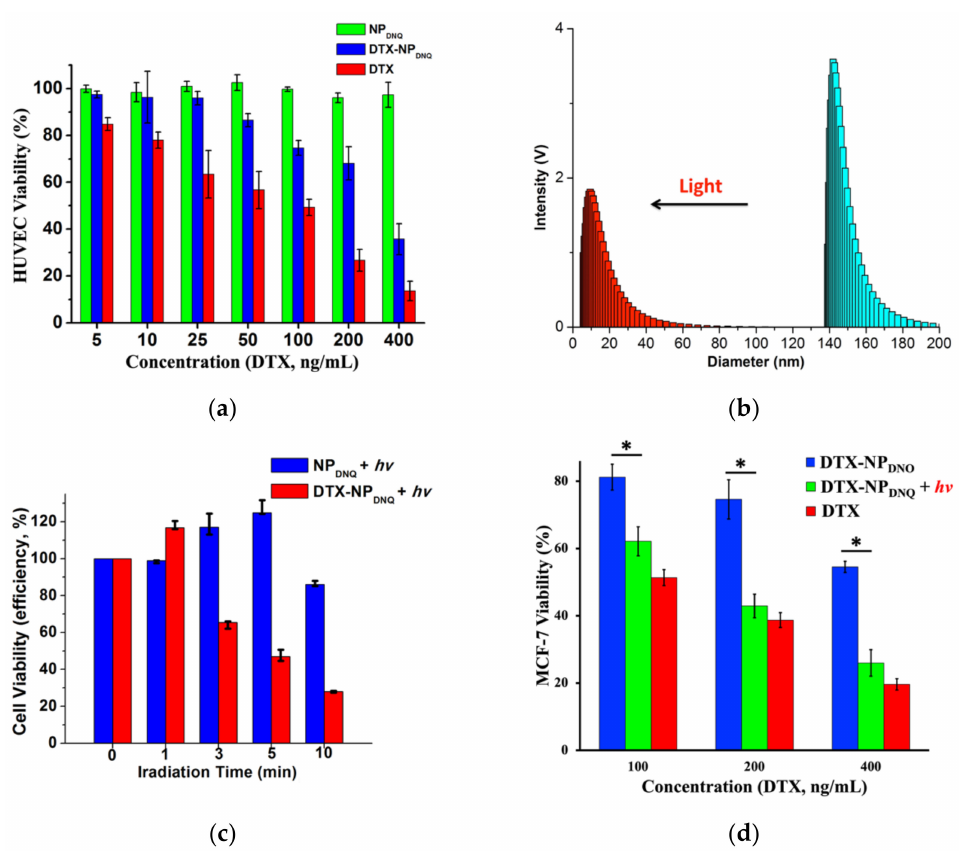
Figure 5. ( a ) Cytotoxicity of HUVECs with NP DNQ (green bar), DTX-NP DNQ (blue bar), and DTX (red bar); ( b ) DLS measurement of size change of DTX-NP DNQ upon UV light irradiation (365 nm, 50 mW/cm 2 , 10 min) in PBS; ( c ) MCF-7 Cells Viability with Light Irradiation ( NP DNQ & DTX-NP DNQ ); ( d ) Cytotoxicity of MCF-7 cells with different concentrations of DTX-NP DNQ (blue bar), DTX-NP DNQ with UV light irradiation (365 nm, 10 min, 50 mW/cm 2 ) (green bar) and DTX (red bar). Data are means ± SD, N = 4, the concentrations of NPs were adjusted to the concentration of DTX by UV-Vis spectroscopy, asterisks indicate p <